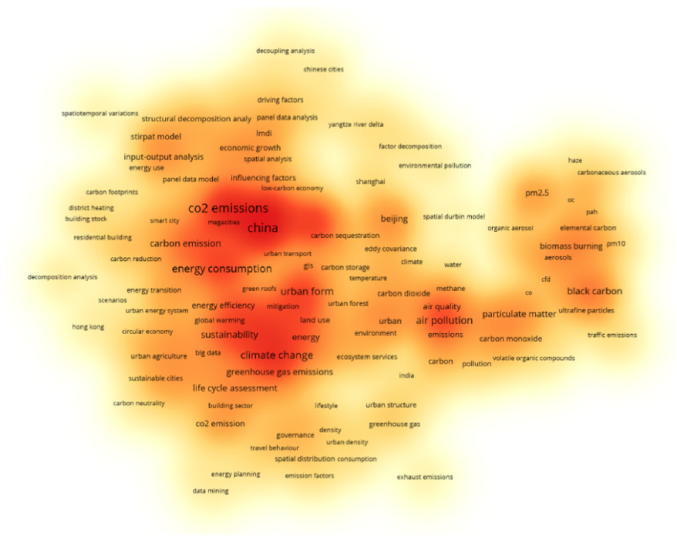
Figure 5. Keywords hotspot map.